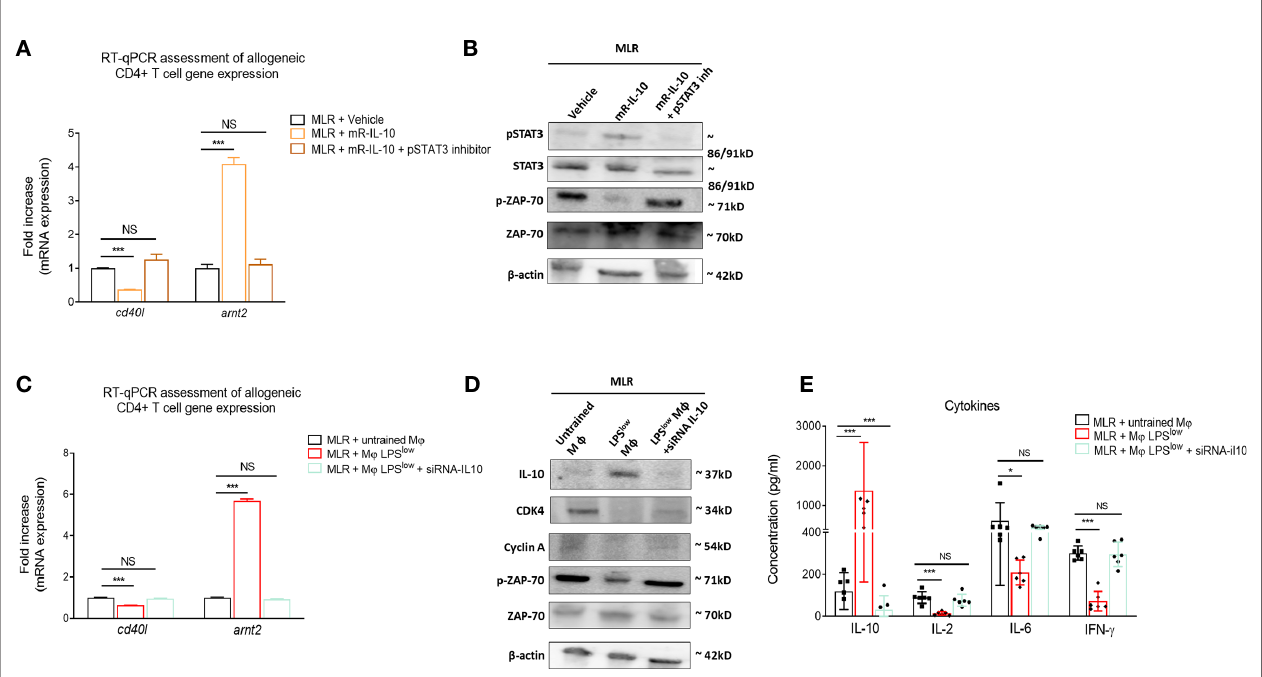
FIGURE 7 | LPS low -trained macrophages hamper allogeneic T-cell activity in an IL-10-dependent manner. (A, B) Puri fi ed CD4 + T cells derived from B10.D2 mice co-cultured with irradiated splenic cells from Balb/c mice were treated with 10 µM of STAT3 inhibitor V or vehicle (PBS + 1%DMSO) for about 30 min before mouse recombinant IL-10 stimulation for 24 h. (A) RT-qPCR assessment of arnt2 and cd40l mRNA expression. (B) Western blot analysis of pSTAT3, STAT3, pZAP70, ZAP-70, and b -actin expression. Representative results of two experiments performed. mR-IL-10, mouse recombinant IL-10. (C, D) Bone marrow derived macrophages obtained from Balb/c mice were either stimulated by PBS (untrained) or trained with LPS low , and subjected to IL-10 mRNA invalidation with small interfering RNA. Cells were then co-cultured with allogeneic CD4 + T cells from the MLR for 72 h in six-plicate. Cells were then analyzed by RT-qPCR for cd40l and arnt2 mRNA expression (C) and by Western blot for IL-10, CDK4, Cyclin A, pZAP70, ZAP-70, and b -actin expression (D) . Representative results of two experiments performed. (E) ELISA measurement of IL-10, IL-2, IL-6, and IFN- g levels in the supernatant of the allogeneic CD4 + T cells co-cultured with wild-type untrained macrophages, LPS low -macrophages, or IL-10 KO LPS low -macrophages. Data represent the mean (pg/ml) ± SEM of six-plicate of two independent experiments. Unpaired T-test and the ANOVA test with Bonferroni correction were used to detect the signi fi cance. NS, non-signi fi cant; *p ≤ 0.05; ***p ≤